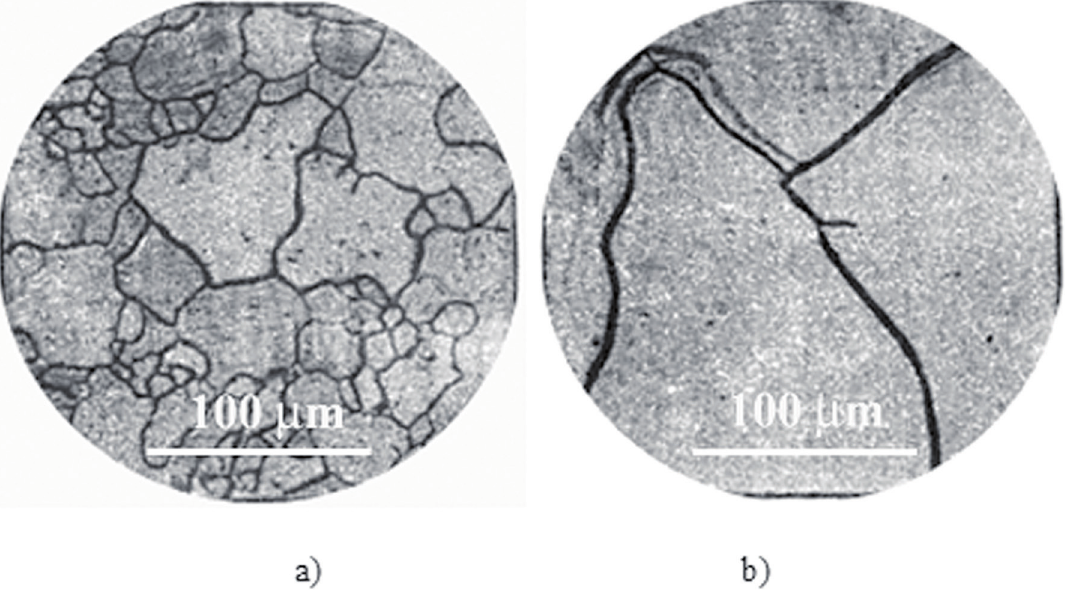
Figure 2: Microstructure of sample composition PtRh20Pd10Ir0.1Au0.1 without impurities: a) before and b) after creep, at 1400 °C and a stress of 5MPa, close to the rupture point (magnification